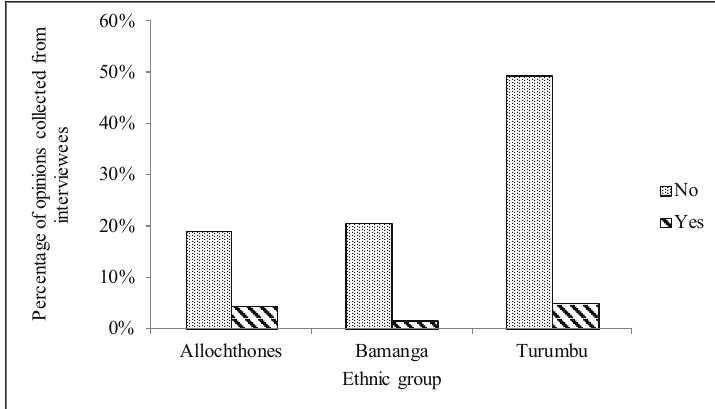
Figure 8. Perceptions of the achievements of local development